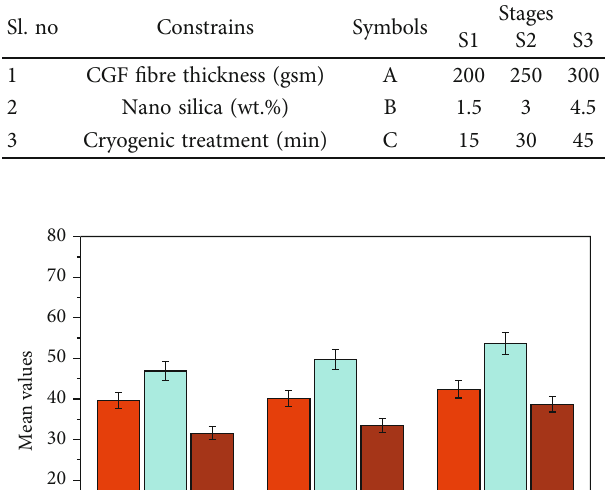
Figure 1: The photographic images of Calotropis gigantea fi bre, nano-SiO Table 2: Constrains and their stages for nanocomposite. Sl. no Constrains